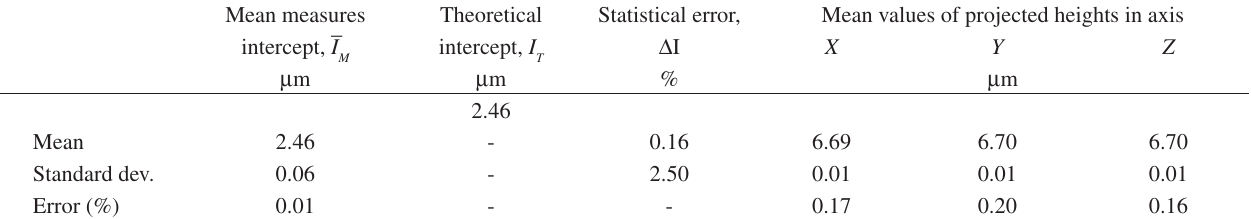
Figure 1. Cross-section of a WC-30 wt.(%)Ni composite. Table 1. Mean values, standard deviation and error in five simulations for 1000 prisms of equivalent grain size of 5 (cid:77) m and aspect ratio of 1/2. The theoretical is 2.46 (cid:77) m. intercept I T